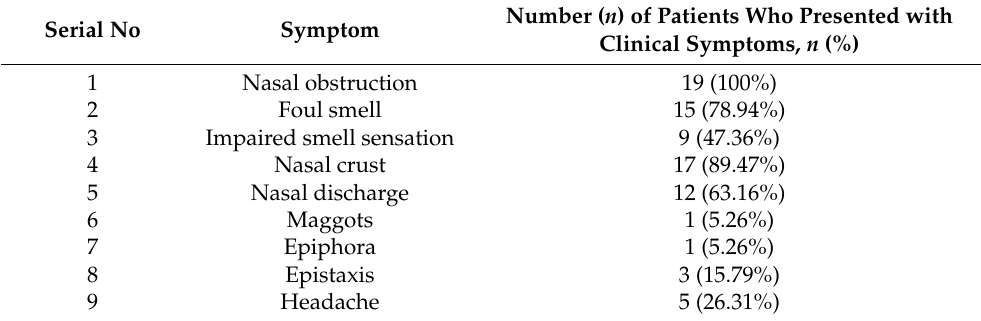
Table 1. The clinical symptoms of the study